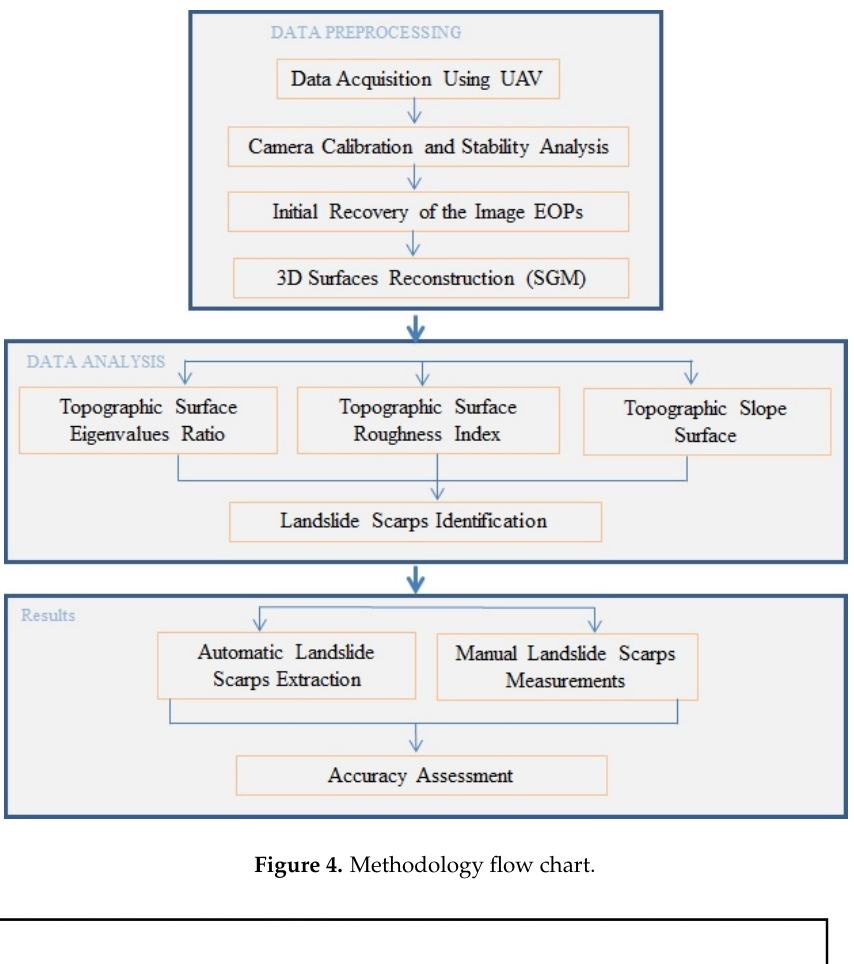
Figure 4. Methodology flow chart.